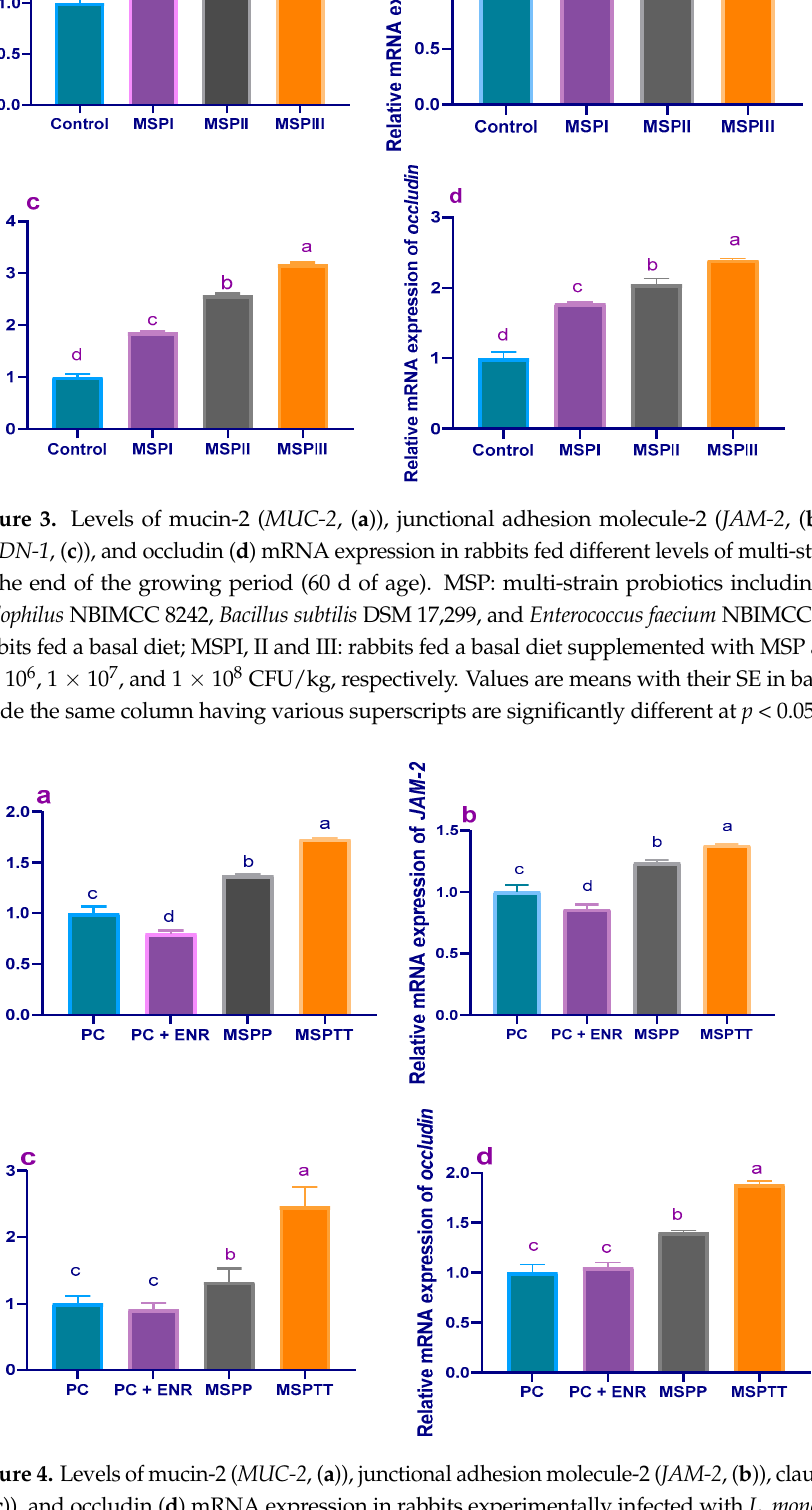
Figure 4. Levels of mucin-2 ( MUC-2 , ( a )), junctional adhesion molecule-2 ( JAM-2 , ( b )), claudins-1 ( CLDN-1 , ( c )), and occludin ( d ) mRNA expression in rabbits experimentally infected with L. monocytogenes and supplemented with multi-strain probiotics either used prophylactically and/or thera- peutically and enrofloxacin treatment (at 90 d of age). MSP: multi-strain probiotics including Lacto- bacillus acidophilus NBIMCC 8242, Bacillus subtilis DSM 17,299, and Enterococcus faecium NBIMCC 8270. PC: positive control (rabbits fed a basal diet and experimentally infected with L. monocyto- genes ); PC + ENR: rabbits fed a basal diet, experimentally infected with L. monocytogenes, and treated with enrofloxacin; MSPP: rabbits fed a basal diet supplemented with MSP at the level of 1 × 10 8 CFU/kg from 30 to 60 days of age and experimentally infected with L. monocytogenes ; MSPTT: rabbits fed a basal diet supplemented with MSP at the level of 1 × 10 8 CFU/kg from 30 to 90 days of age and experimentally infected with L. monocytogenes . Rabbits were orally administered with L. monocyto- genes at the concentration of 10 7 CFU/mL at 60 days of age. Values are means with their SE in bars. a–d : Means inside the same column having superscripts are significantly different at p < 0.05. The results of a gene expression analysis of cytokine-related genes are illustrated in Figures 5 and 6. Before experimental infection with L. monocytogenes (60 d of age), the rel- ative expression levels of IL-8 (Figure 5a) and IL-6 (Figure 5b) genes were significantly ( p < 0.05) decreased with increasing the levels of dietary MSP, while TNF- α (Figure 5c) and IL-1 β (Figure 5d) expression levels were significantly ( p < 0.05) decreased in rabbits fed MSP at levels of 1 × 10 7 and 1 × 10 8 CFU/kg unlike the control group. Moreover, IL-10 (Figure 5e) and TGF- β 1 (Figure 5f) gene expression levels were significantly ( p < 0.05) up- regulated, especially with higher MSP supplementation levels. At 90 d of age, other re- markable findings emerged from the data analyses were the prominant decreases in the expression levels of the IL-8 (Figure 6a), IL-6 (Figure 6b), TNF- α (Figure 6c), and IL-1 β (Figure 6d) genes in rabbits fed MSP over the whole rearing period (MSPTT) and those treated with enrofloxacin. Additionally, the enrofloxacin- and prophylactic and therapeu- tic MSP (MSPTT) treated groups, followed by prophylactic MSP (MSPP), displayed higher ( p < 0.05) IL-10 (Figure 6e) and TGF- β 1 (Figure 6f) transcriptional levels compared with the experimentally-infected group. Moreover, the most prominent ( p < 0.05) upregulation